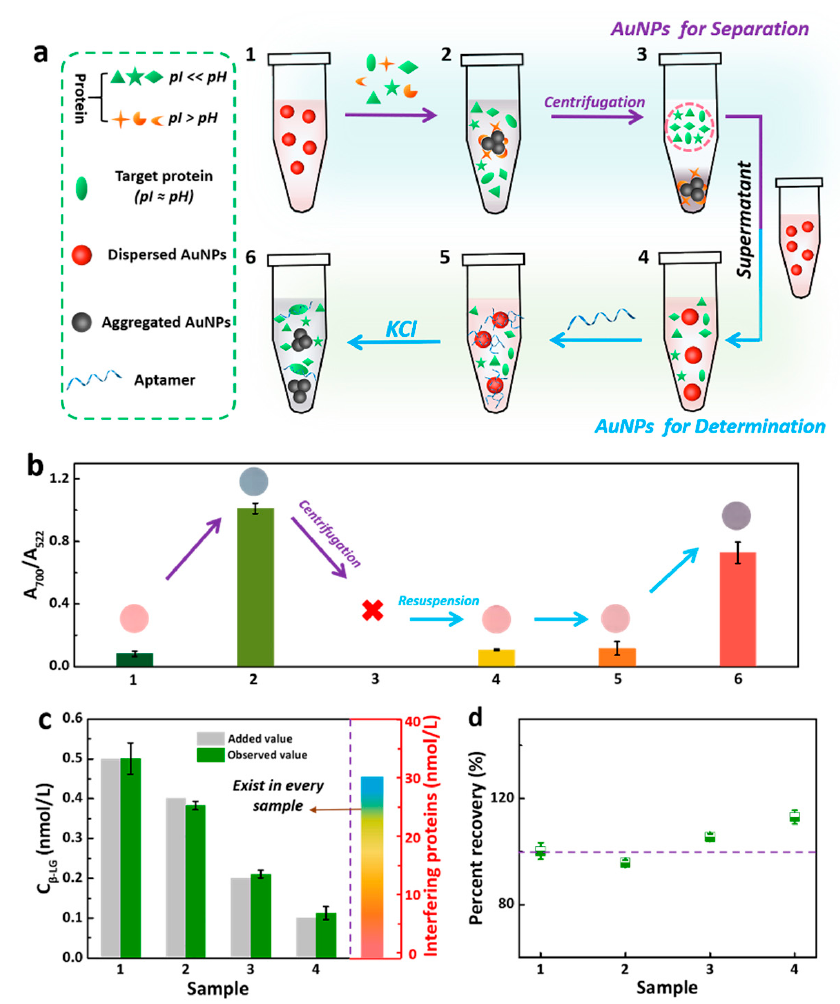
Figure 3. ( a ) Schematic diagram of the separation of interfering proteins and detection of target proteins relying on the dual function of AuNPs. Ten microliters β -LG and six kinds of interfering proteins (10 μ L, 30 nM) were added into 500 μ L AuNPs. The sample was mixed thoroughly and centrifuged at 12,000 r/min for 15 min. Then, 10 μ L supernatant was added to another 500 μ L AuNPs. Thus, 10 μ L of 0.007 μ M aptamer was mixed. After the addition of 100 μ L 20 mM salt, the color change and absorbance value at 522 nm and 700 nm were recorded. ( b ) Evolution of the A 700 /A 522 ratio of AuNPs corresponding to processes in Figure 3a (Inset: the corresponding photographs). ( c ) Analysis of different concentrations β -LG in the mixture sample, which were prepared by mixing the various concentrations (0.5, 0.4, 0.2, 0.1 nM) β -LG and six kinds of interfering proteins (BSA, γ -globulin, casein, LZM, lactoferrin (LF) and protamine), the concentration of each interfering protein is 30 nM. ( d ) Recoveries of β -LG in the interfering proteins removal assay.